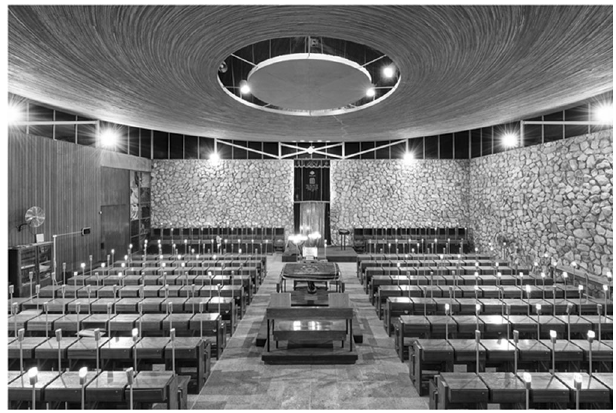
Fig. 5 The Central Synagogue of Nazareth Illit. Architect Nahum Zolotov, 1968, Interior view facing the bimah and the Torah Ark. (Eli Singalovski, Nazareth Illit #1 , 2018. Archival pigment print, 100 × 67 cm).